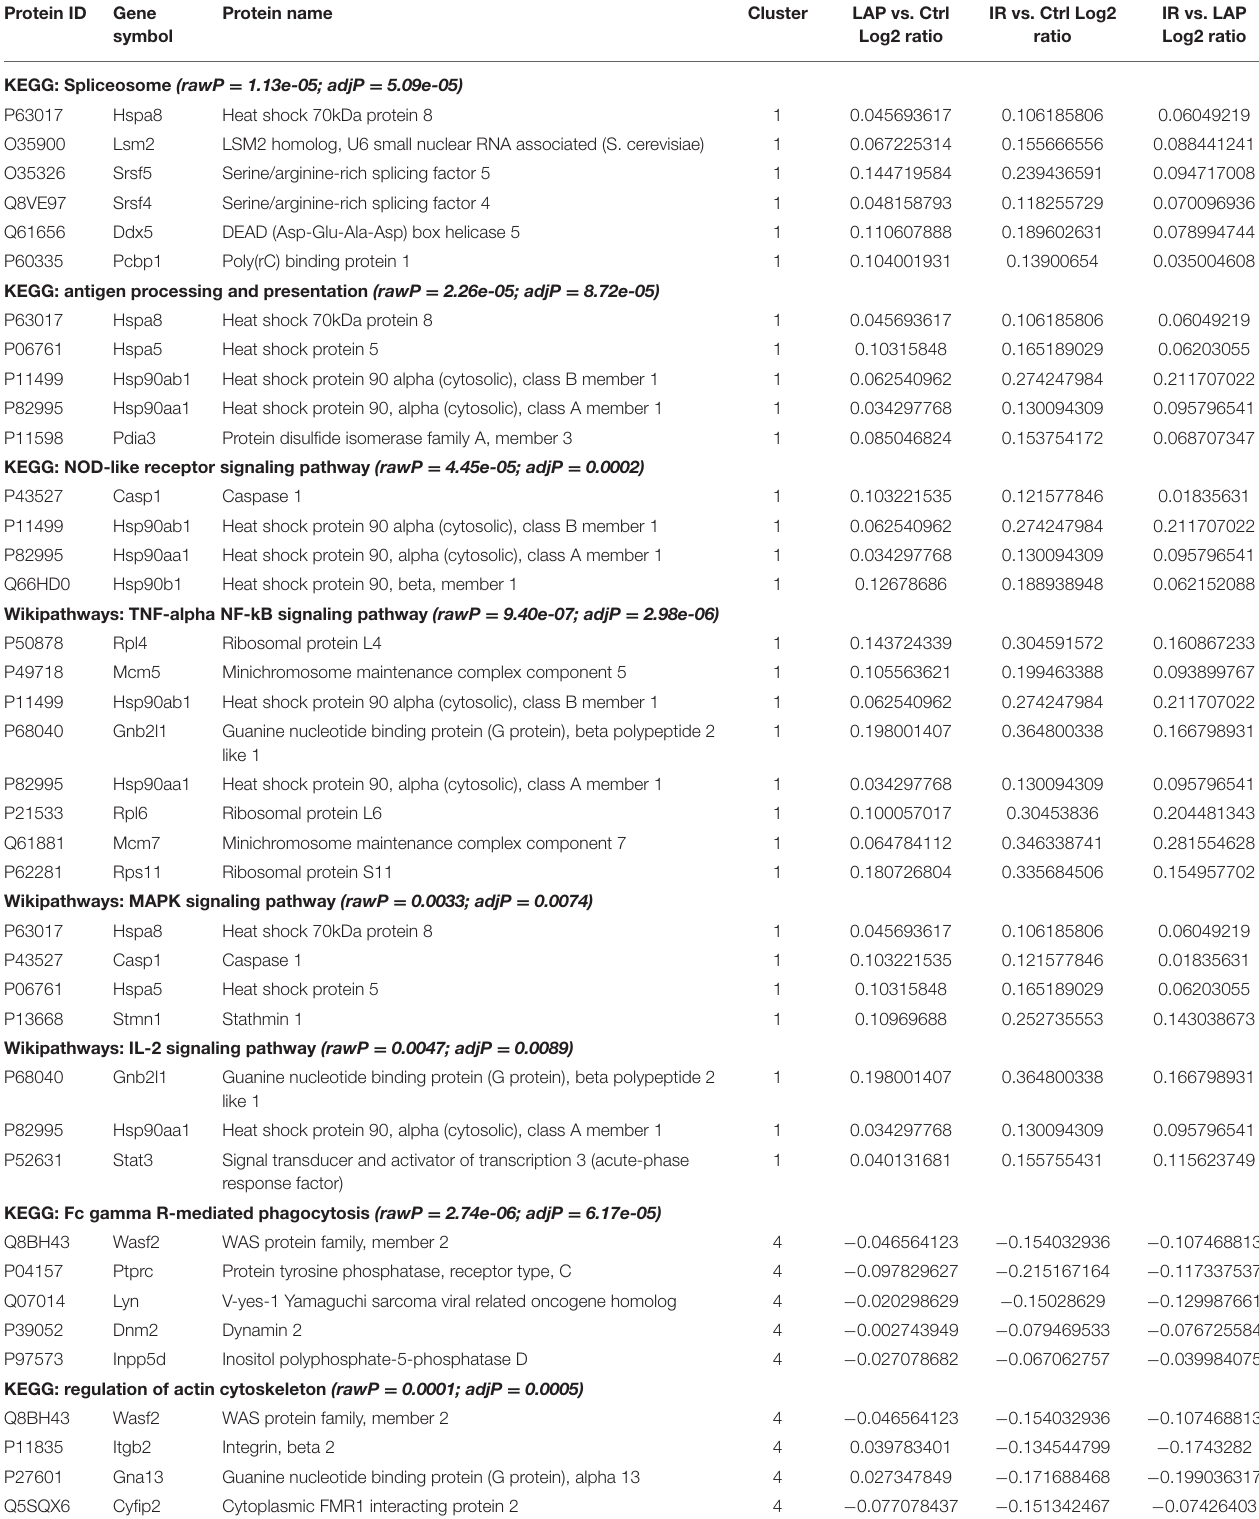
TABLE 2 | Major functional classification. Protein ID Gene Protein name Cluster LAP vs. Ctrl symbol